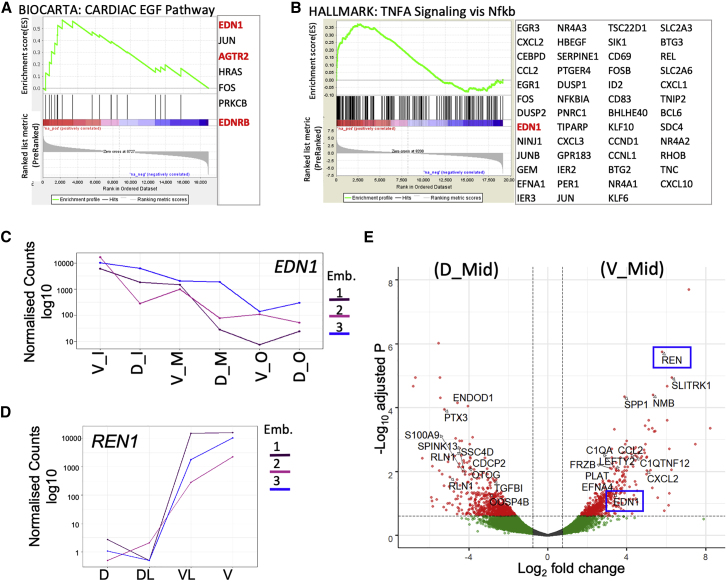
Spatial Molecular Polarization across the Ao Wall and Surrounding Stroma (LCM-Seq2)(A and B) Enrichment plots for V_Inner versus D_Inner “Cardiac EGF” pathway (A) and V_Mid versus D_Mid TNF-α signaling via NF-κB (B). Contributing genes are shown. Endothelin- and angiotensin-related genes are highlighted in red.(C) LCM-seq2: the expression levels of EDN1 decrease with distance from the Ao lumen (LCM-seq2) (adjusted p value [p.adj] = 2 × 10−7; N = 3, indicated by different colors).(D) LCM-seq1: the expression levels of REN increase significantly from D and DL to V and VL.(E) Volcano plot of significant genes, V_Mid versus D_Mid, with secreted factors marked (positive loading versus negative loading, respectively). REN (most significant secreted factor (p.adj = 1.8 × 10−6) and EDN1 are marked by blue boxes.